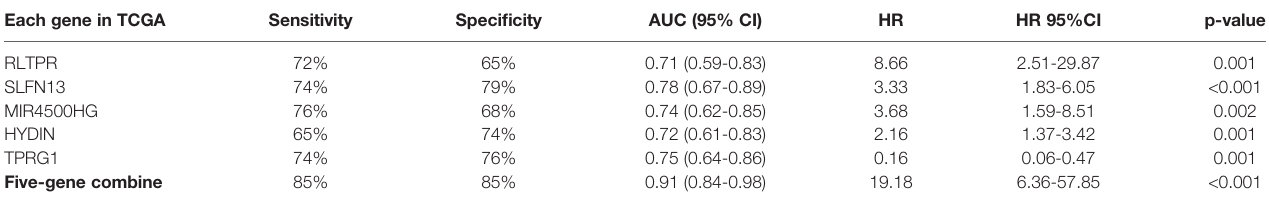
TABLE 2 | Recurrence prediction using gene expression in TCGA training cohort. Each gene in